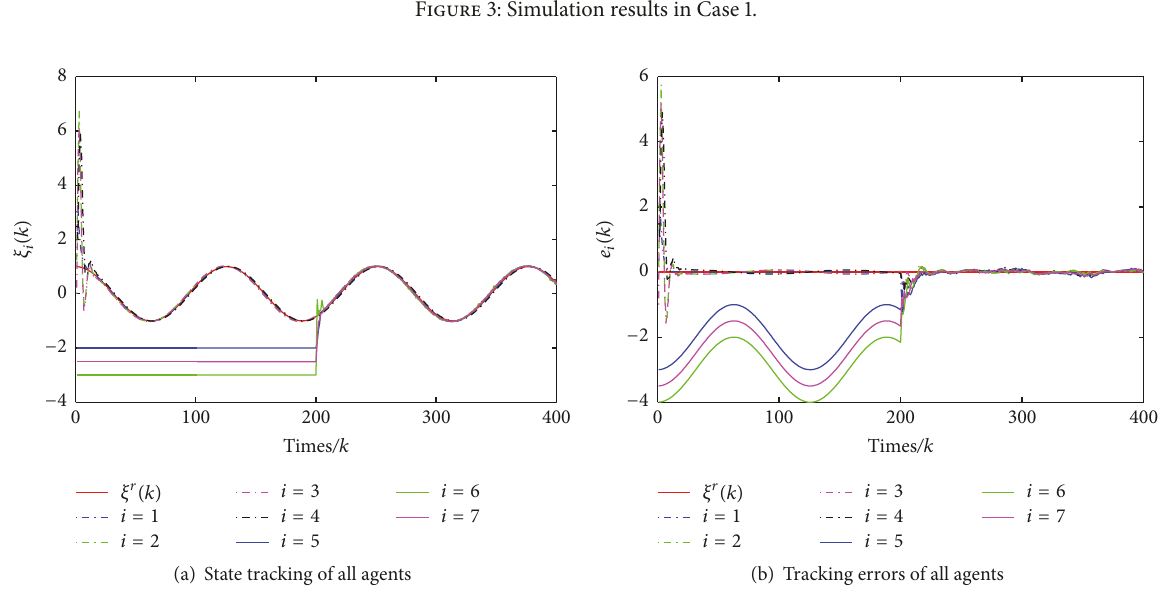
Figure 4: Simulation results in Case